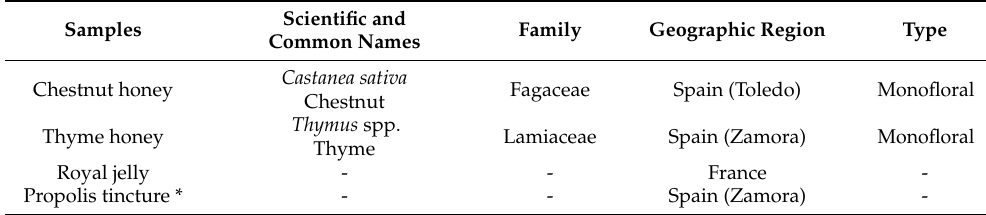
Table 1. Honey and bee product samples.